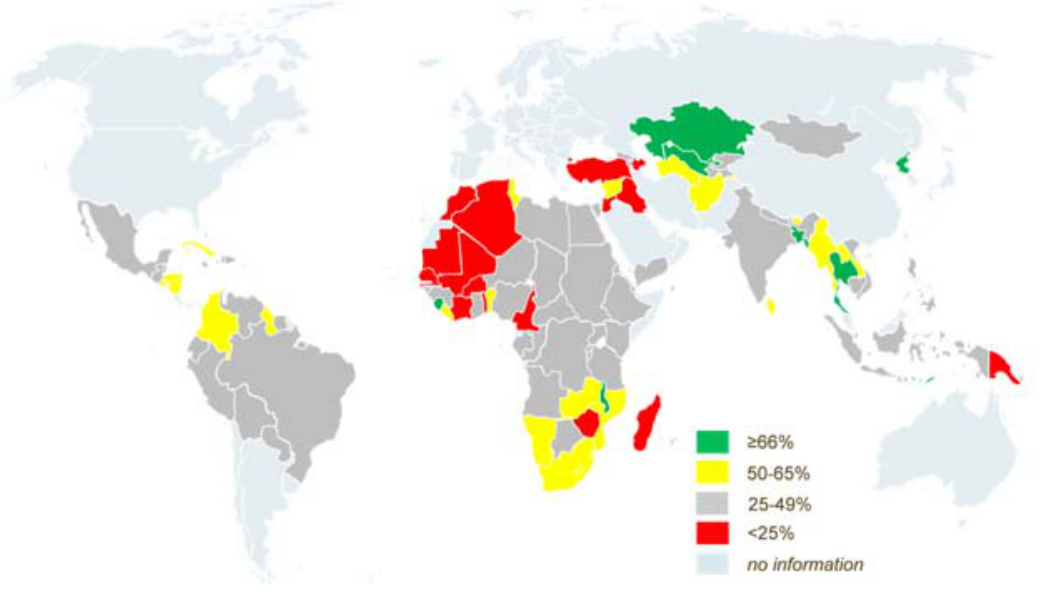
Figure 1. Map of ORS use rates around the world. (Data sources: Demographic and Health Surveys, Multiple Indicator Cluster Surveys and national survey